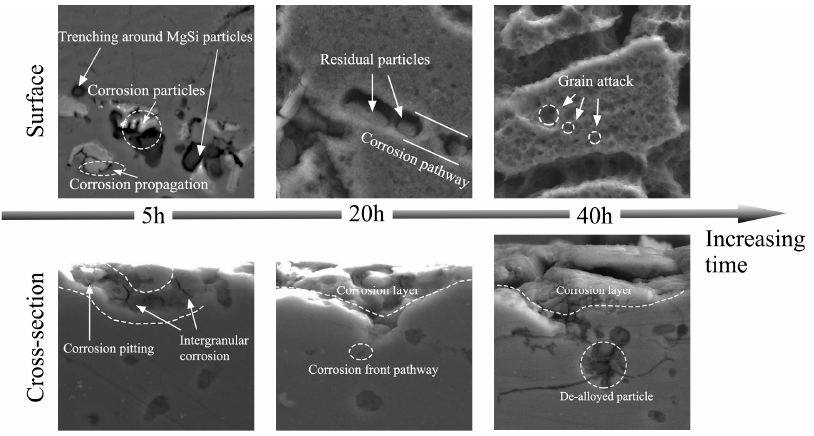
Figure 8. Corrosion evolution of the Al-Mg-Si alloy after immersion in 3.5 wt % NaCl solution.